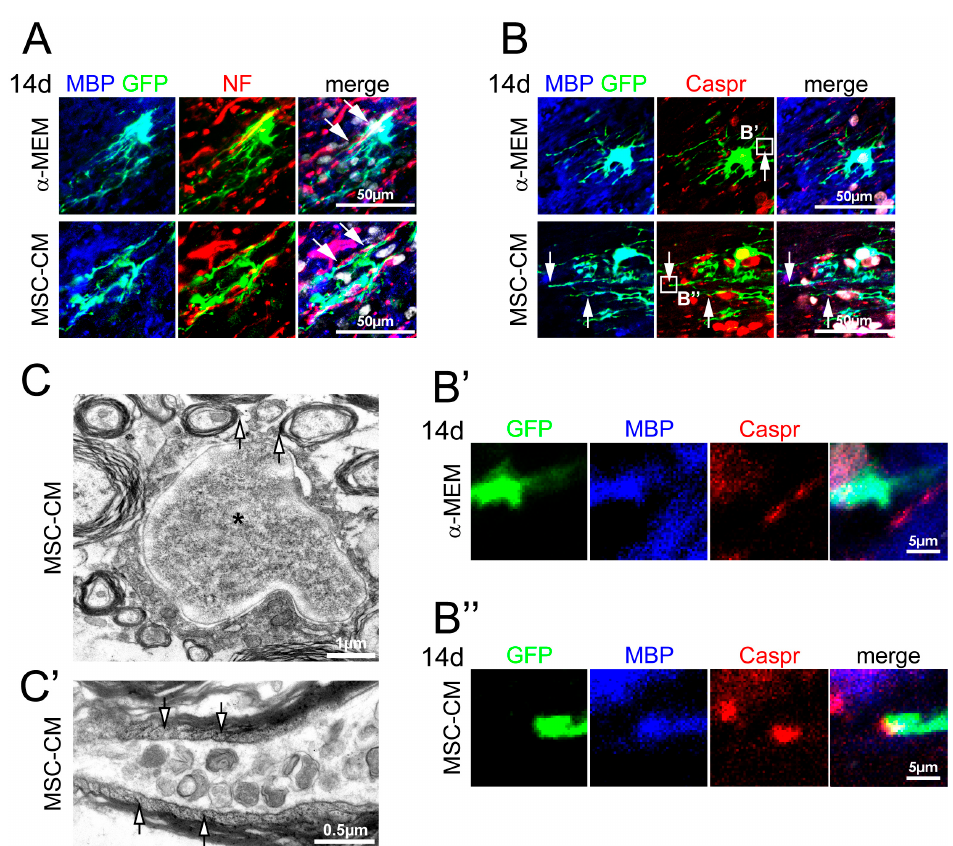
Figure 5 . MSC-CM pre-treated aNSCs were able to generate myelinated segments. ( A ) Representative pictures of MBP-/GFP-/neurofilament-stained spinal cord sections at 14 days post-transplantation. For both α -MEM and MSC-CM pre-treated and transplanted cells, we observed an alignment of MBP-positive segments with neurofilament (NF)-positive axons (arrows). Nuclei are depicted in white. ( B ) MBP-positive processes of MSC-CM pre-stimulated cells often ended in Caspr-positive paranodes (arrows). Nuclei are depicted in white. Higher magnifications are depicted in ( B’ ) for α -MEM and in ( B’’ ) for MSC-CM pre-stimulated aNSCs. ( C ) Representative electron micrograph of a GFP-positive cells (asterisk: nucleus) 14 days post-transplantation. Chromogenic GFP-immunoreactivity (dark precipitate) identified myelinating processes (arrows). ( C’ ) GFP expression was also detectable in the cytoplasm of paranodal loops